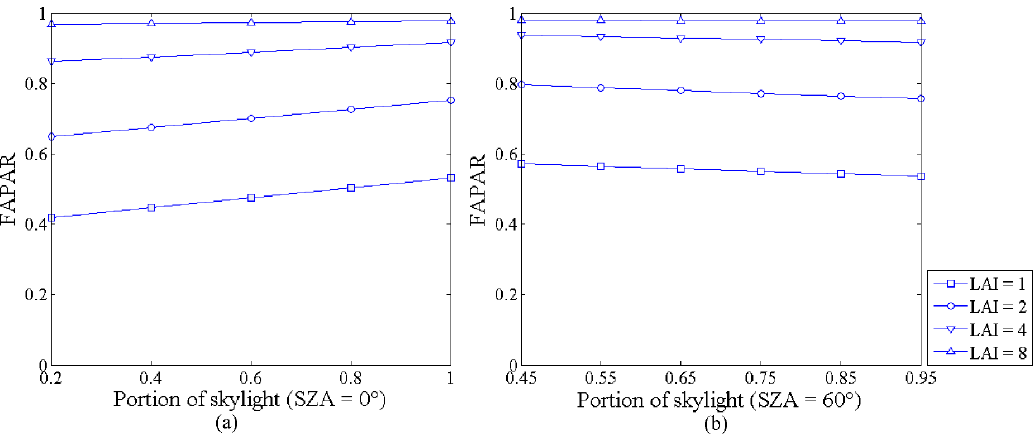
Figure 6. Effects of skylight proportions on FAPAR under VIS = 30 km and: ( a ) SZA = 0°; and ( b ) SZA = 60°.